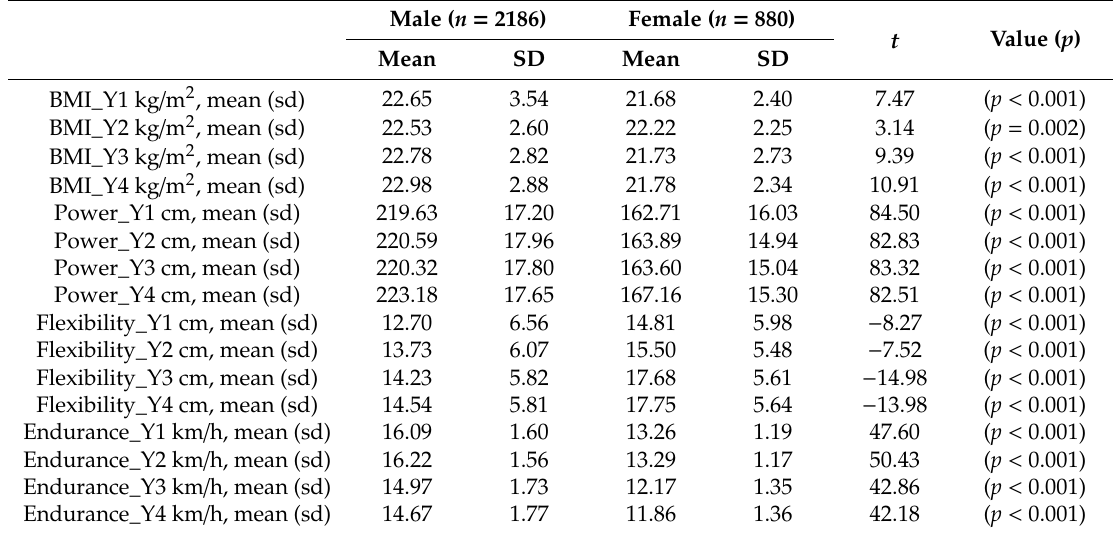
Table 2. Means, standard deviations (SD), and sample size (N) of main